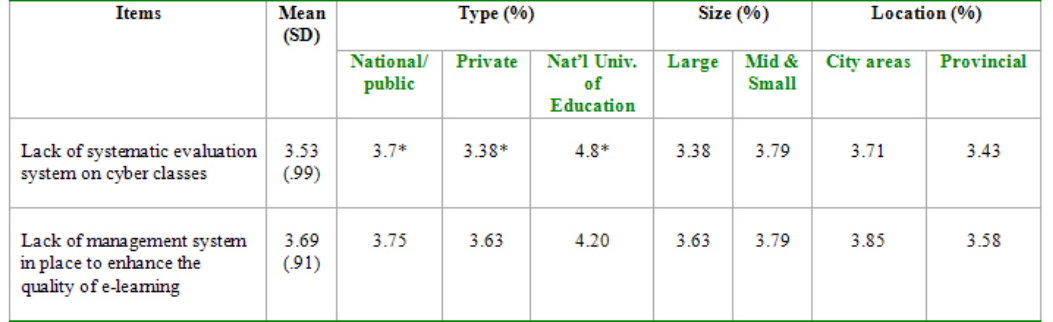
Table 9. Awareness on the Evaluation and Quality Management